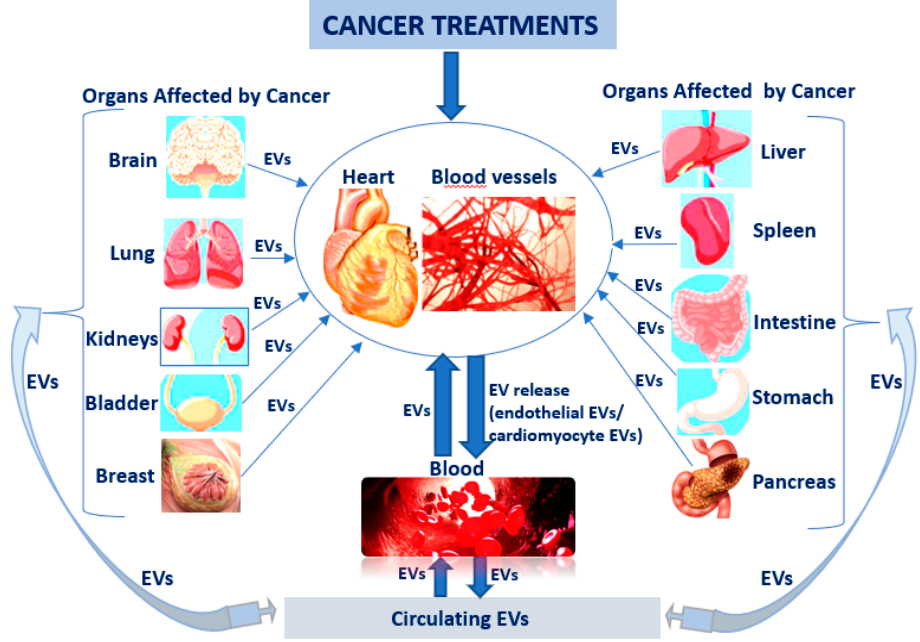
Figure 2. EVs as key biomarkers in cardio-oncological pathology: cancer therapy affects the heart and blood vessels and generates the release of endothelial and cardiomyocyte EVs into circulation, which can subsequently disturb the other organs; EVs released into circulation from apoptotic, activated or tumour cells can reach any other organ, including heart and blood vessels.